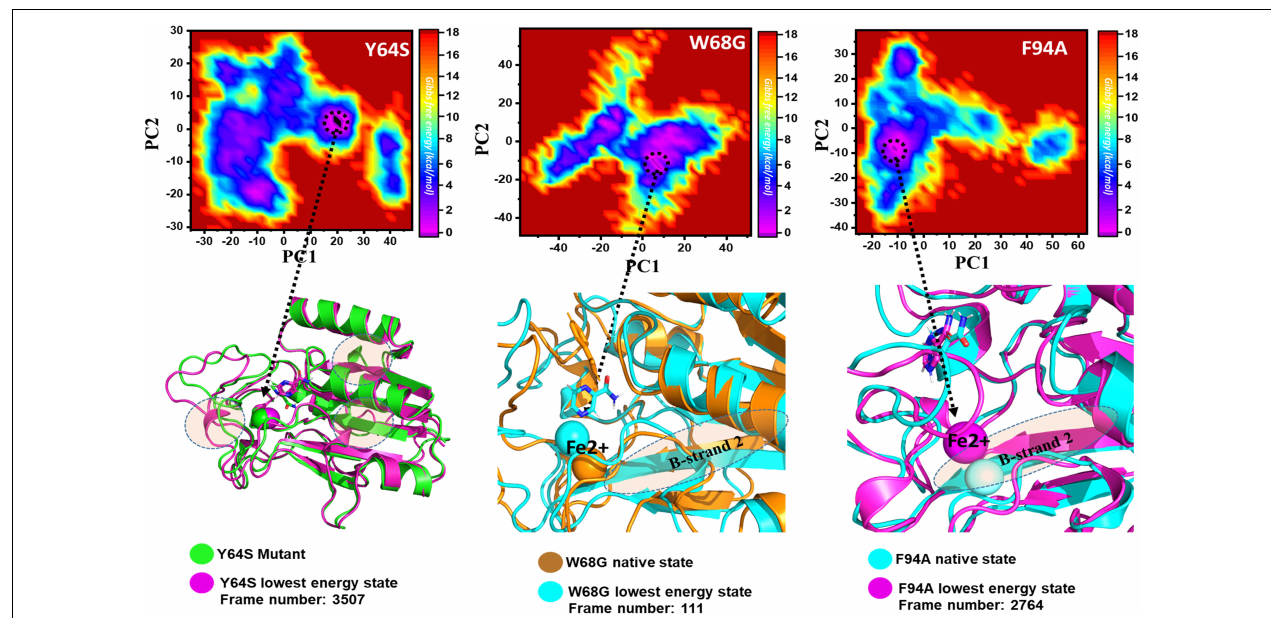
FIGURE 8 | Structural rearrangement of Fe 2 + and the other regions in the protein given above (Y64S, W68G, and F94A mutants). The lowest energy conformation from each trajectory was extracted and compared with the native state. The circle represents the lowest energy